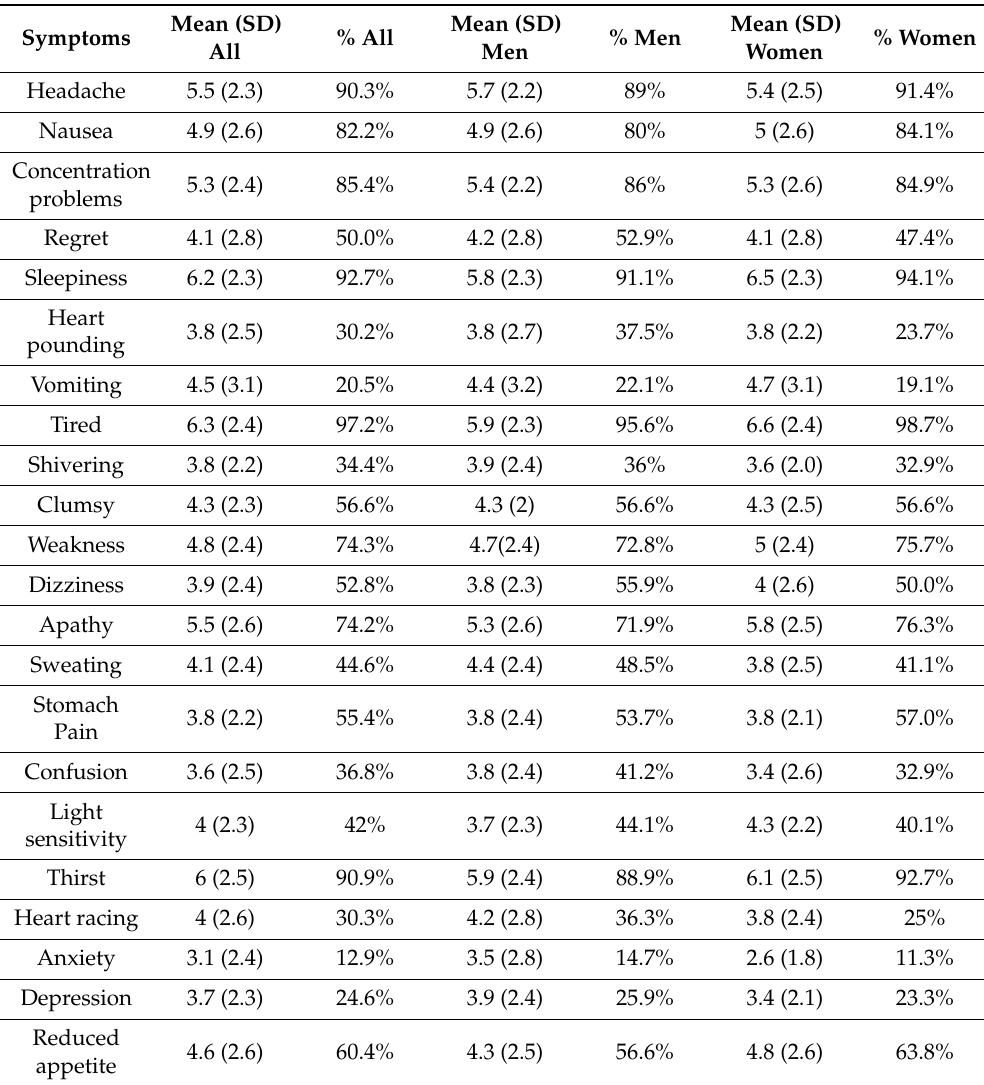
Table 3. Presence and severity of individual hangover symptoms after alcohol consumption and reaching an eBAC 0% ≤ eBAC <